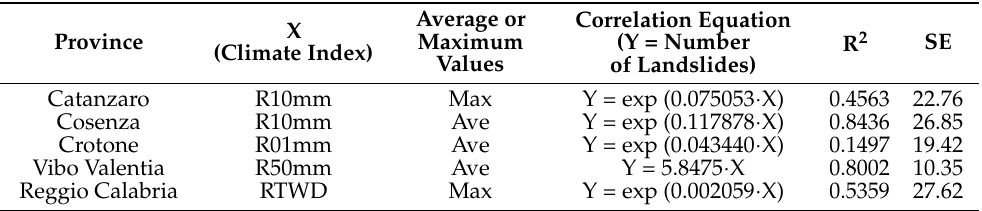
Figure 2. Two examples of the best comparisons between number of landslides and climate indices for the whole Calabria region, obtained with the average values of R10mm ( a , b ) and R10mm ( c , d ). Table 3. The best fitting models between the climate indices (for average or maximum values) and the annual number of landslides occurred in each province of